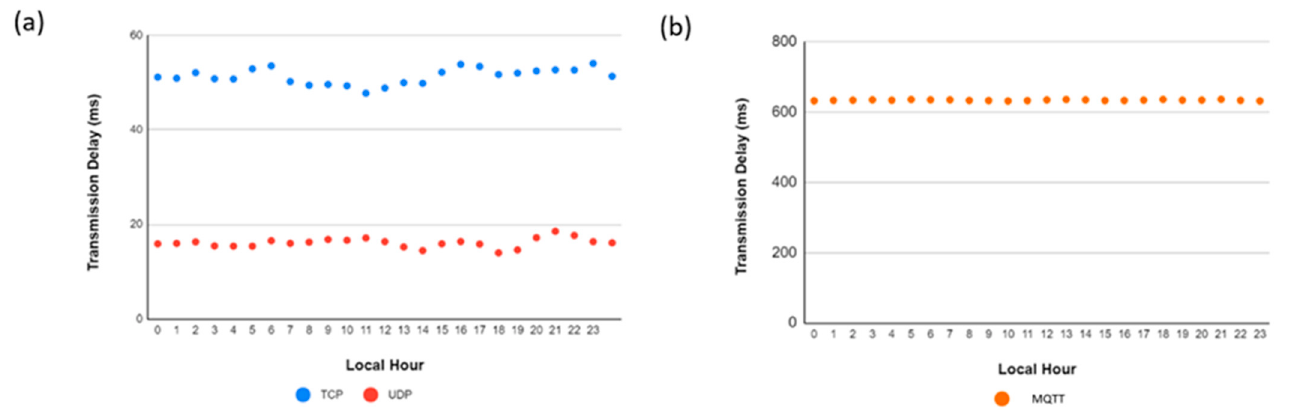
Figure 6. ( a ) Hourly distribution of the transmission delay during a 24 ‐ h period for TCP (blue dots) and UDP (red dots). ( b ) Hourly distribution of the transmission delay during a 24 ‐ h period for MQTT (orange dots).